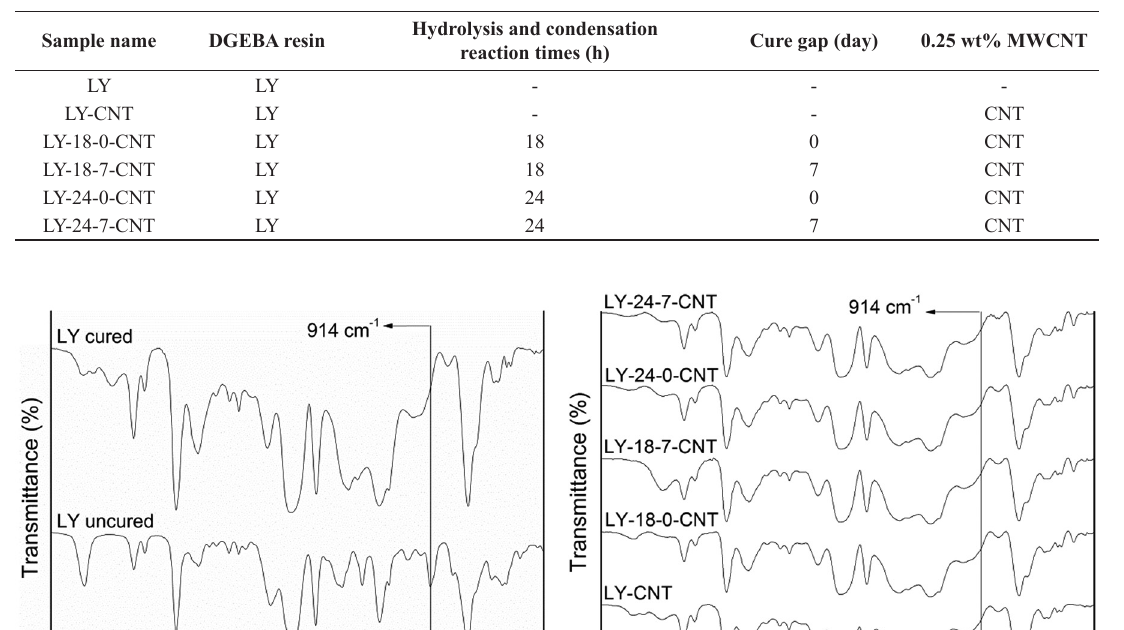
Table 1. Schematic nomenclature of the samples.